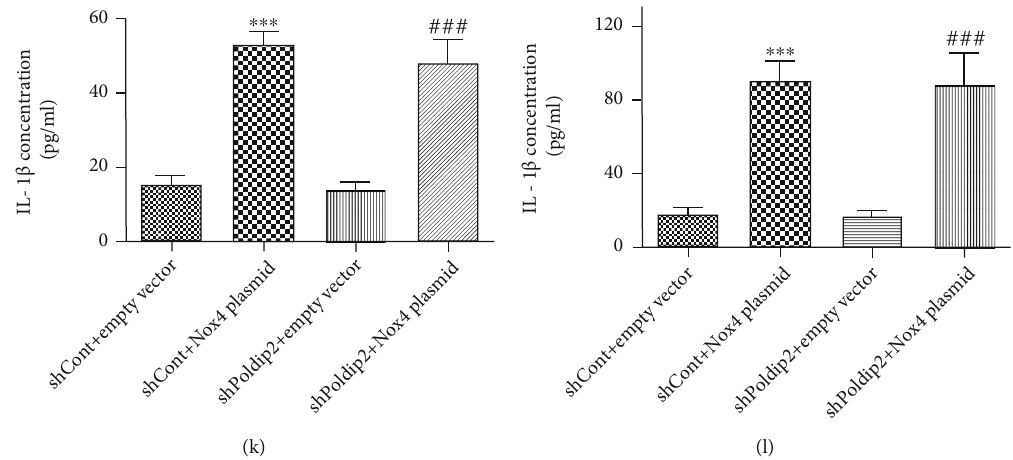
Figure 4: Upregulation of Nox4 increased oxidative stress and in fl ammation. (a, b) Con fl uent A549 and Beas-2B cells were transfected with Nox4 plasmid or the empty vector for 72 h, and the e ffi ciency of Nox4 upregulation was veri fi ed by Western blotting and quantitatively analyzed. Con fl uent shCont and shPoldip2 cells were cotransfected with Nox4 plasmid or the empty vector for 72 h. (c, d) The protein levels of Poldip2, HO-1, and COX-2 were detected by Western blotting and quantitatively analyzed. (e, f) The production of intracellular ROS was detected by fl ow cytometry. (g – l) The expression levels of PGE2, TNF- α , and IL-1 β in the supernatant were detected by ELISA. Bars are mean ± SD of 3 independent experiments. ∗∗∗ P < 0 : 001 vs. shCont + empty vector, ∗∗ P < 0 : 01 vs. shCont + empty vector, ∗ P < 0 : 05 vs. empty vector, ### P < 0 : 001 vs. shPoldip2 + empty vector, and ## P < 0 : 01 vs. shPoldip2 + empty